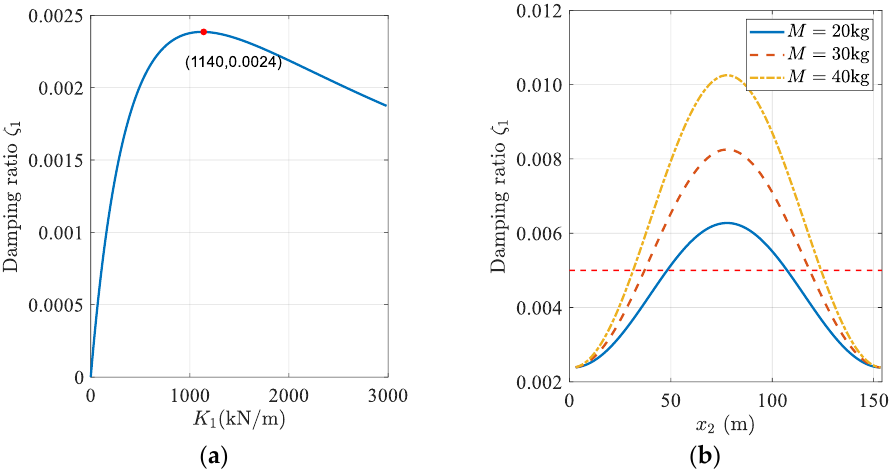
Figure 10. Dampers’ design targeting the cable’s first vibration mode ( ϕ = 0.5, x 1 / L = 0.02 , ρ = 1): ( a ) parameter optimization of the HDR damper; ( b ) location parameter optimization of the TM-HDR-D.